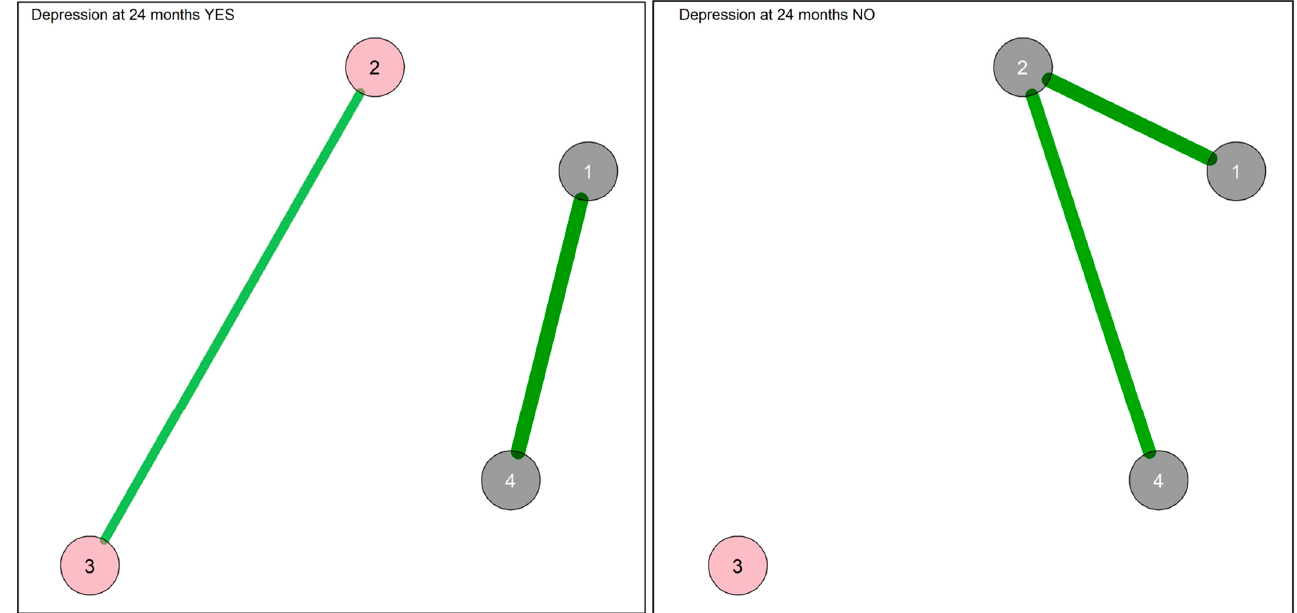
Figure 1. Network of symptoms with Bayesian estimation and walktrap community detection in the subgroups with and without MDE at 24 months. 1: Depression; 2: Somatic; 3: Agitation; 4: Anxiety. Each node corresponds to a symptom cluster identified in the previous symptom reduction. Nodes are connected with lines (edges) that represent the strength of association between nodes. Green edges suggest a positive association, whereas red edges suggest a negative association. The thickness of the edge represents the edge’s weight, which is an indication of the strength of the association. The thicker the edge, the greater the weight and the stronger the association. In this network, all edges connecting the nodes are green (positive correlation), with their width indicating the strength of their connections. Node colors indicate the community of the nodes. In the MDE YES network: pink for agitation and somatic symptoms and grey for depression and anxiety. In the MDE NO network: pink for agitation and grey for depression, anxiety and somatic symptoms.